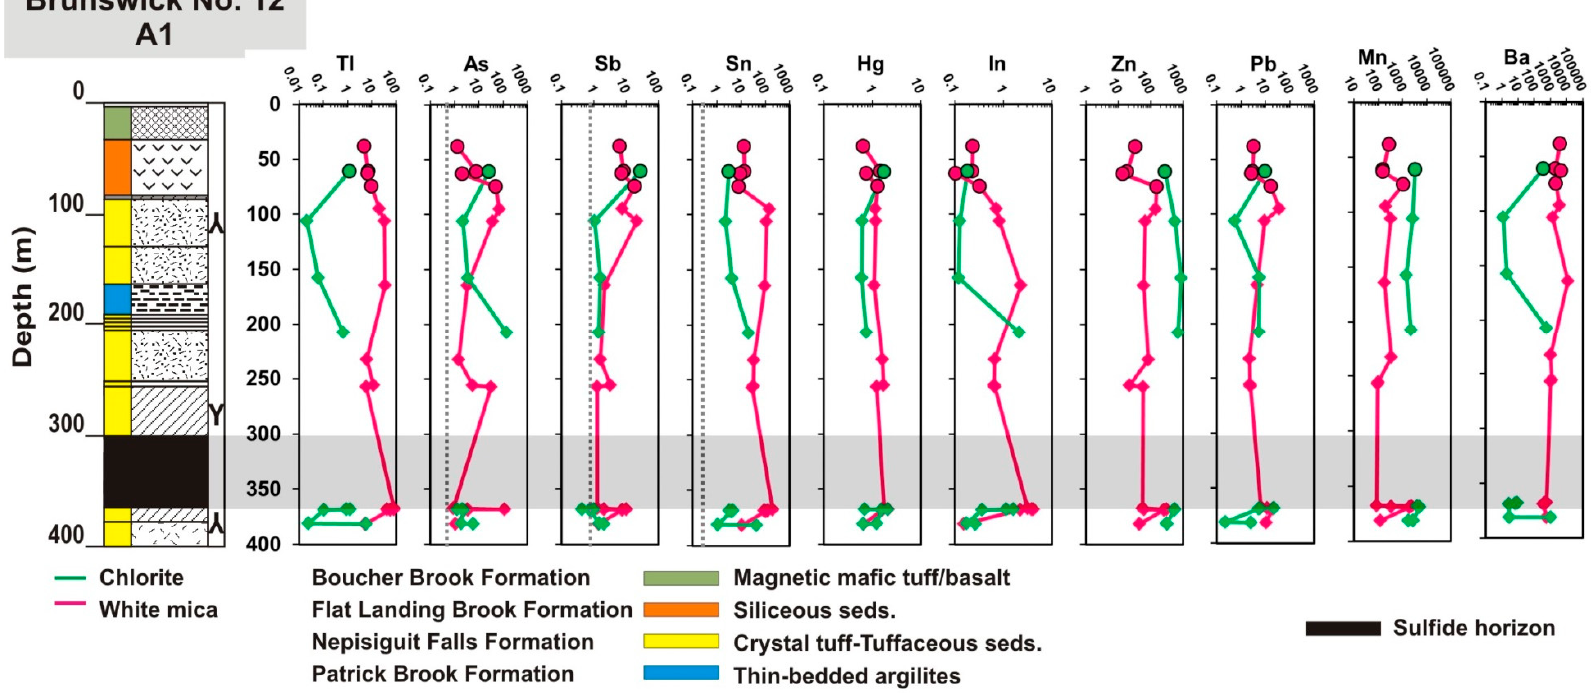
Figure 10. LA-ICP-MS geochemical data profiles illustrating fluid-mobile elements, as well as Zn, Pb, Mn, and Ba content (in ppm) of chlorite (green symbols and lines) and white mica (pink symbols and lines) plotted with respect to stratigraphic profile of the Brunswick No. 12 deposit along drill hole A1 (see Supplementary Tables S6 and S7). Black outline on symbols denotes hanging wall.